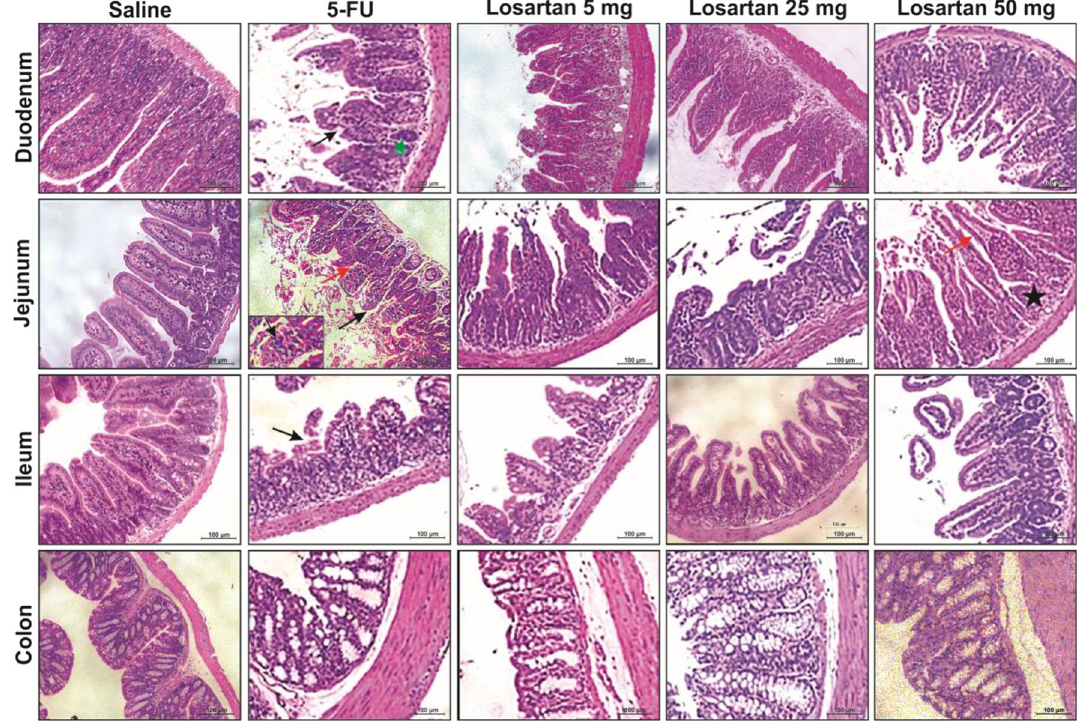
Figure 1. Histopathological analysis of intestinal segments of the duodenum, jejunum, ileum and colon of animals submitted to intestinal mucositis (IM) induced by 5-fluorouracil. Photomicrographs on a 100 μm scale demonstrated that the animals in the saline group maintained the integrity of the intestinal mucosa, with villi and crypts without damage, as well as the absence of inflammatory infiltrate. The 5-FU caused the loss of integrity, structure and shortening of the villi (black arrow), injury and disruption of the crypts with the presence of vacuolization (green arrow) and the presence of inflammatory infiltrate (red arrow). Losartan treatment at a dose of 50 mg/kg decreased the effects caused by 5-FU, improving the appearance of villi (red arrow) and crypts (black arrow).